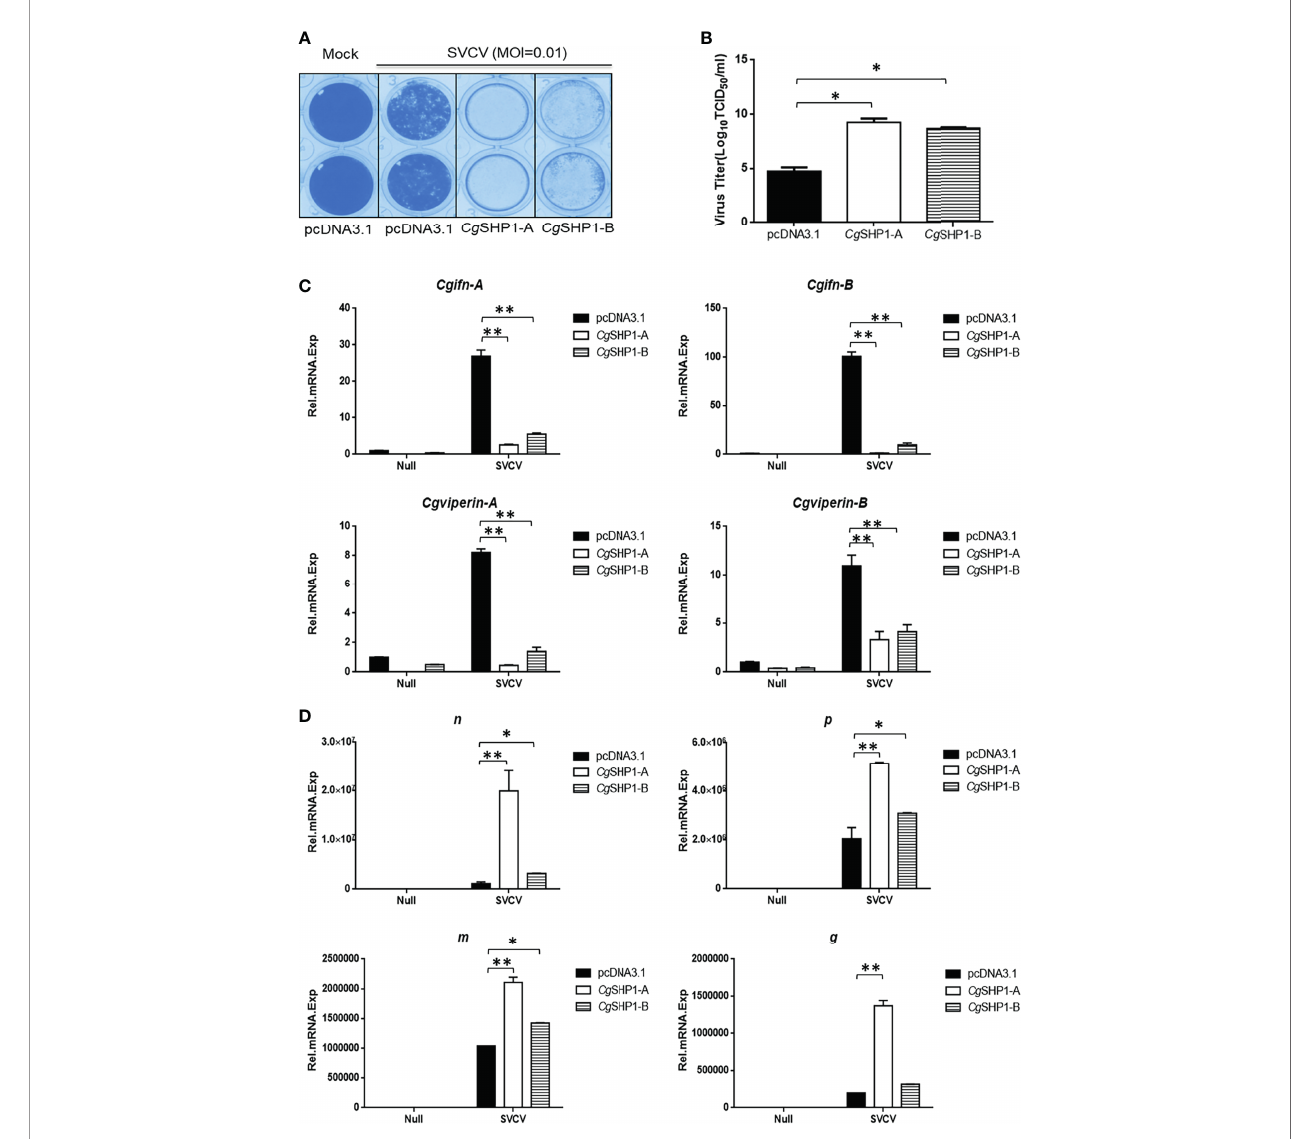
FIGURE 8 | Cg SHP1-A and Cg SHP1-B attenuate the cellular antiviral response. (A, B) Enhance ofvirus replication byoverexpression of Cg SHP1-A or Cg SHP1-B. GiCB cells were transfectedwith 0.5 m g pcDNA3.1- Cg SHP1-A or Cg SHP1-B or empty vector.At 24 h post-transfection, cells were infected with SVCV (MOI = 0.01) for 48 h (A) . Viral titer was measured according to the methodof Karber (B) . (C) Cg SHP1-A and Cg SHP1-B inhibit the expression of Cgifn-A and Cgifn-B , Cgviperin-A and Cgviperin-B . GiCB cells were transfectedwith 2 m g pcDNA3.1- Cg SHP1-A or Cg SHP1-B or empty vector.At 24 h post-transfection,cells were untreated or infected with SVCV (MOI= 1). After 24 h infection,the WCLswere detectedfor qPCR analysis. (D) The mRNA levelsof cellular n , p , m and g. The same samples were prepared similarly as described above for (C) . The relative transcriptional levelswere normalizedto the transcriptional level of the eef1a1l1 gene and were represented as fold induction relative to the transcriptional level in the control cells. Data are expressedas mean ± SEM,n = 3. Asterisksindicate signi fi cant differences fromcontrol values (* p < 0.05, ** p <